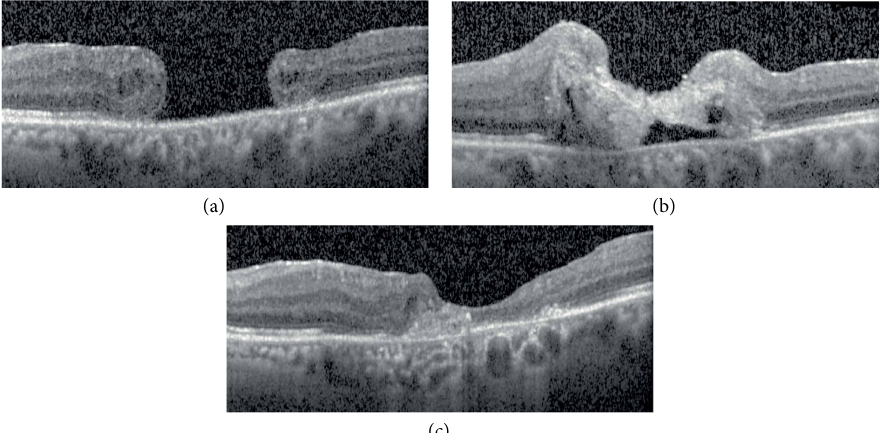
Figure 2: Optical coherence tomographic images of the Case 2 before the operation (a), and one week (b), and 3 months (c) after the